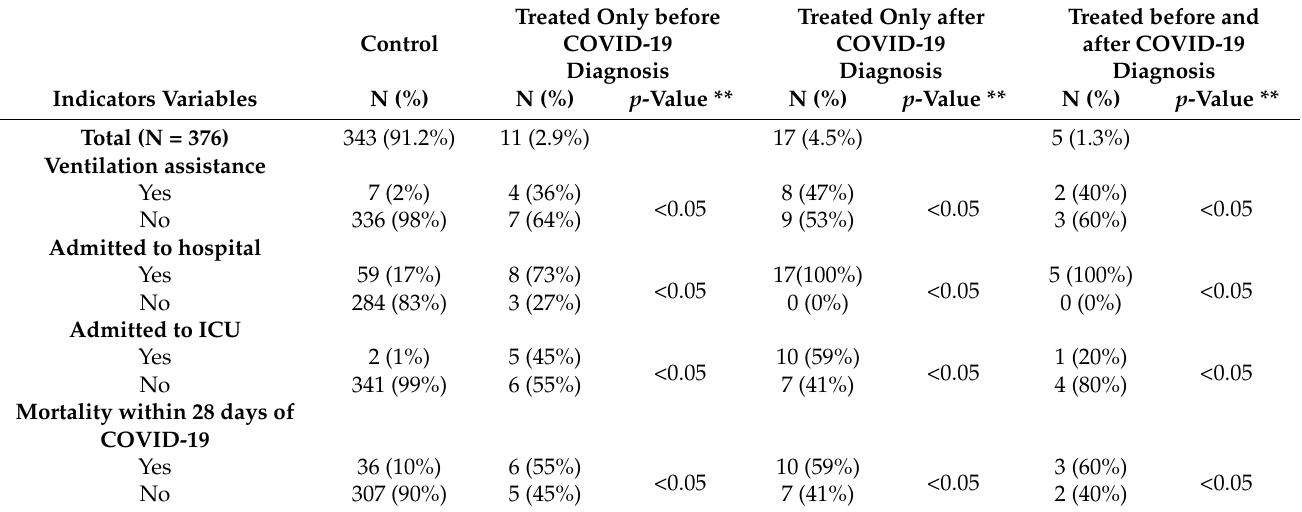
Table 3. Summary of variable values for control and hydrocortisone groups.